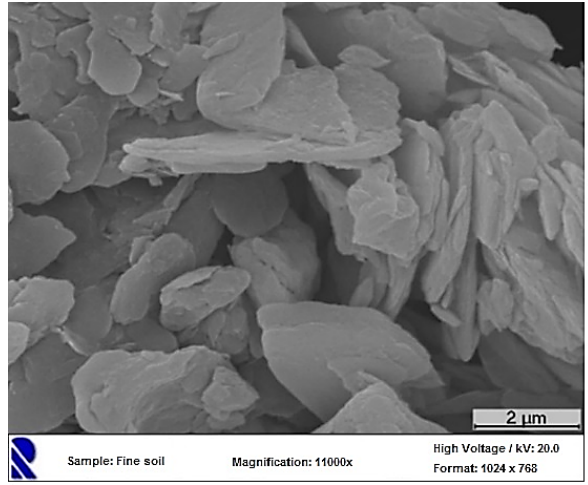
Figure 3: SEM image of the fine soil, magnification of 11000x